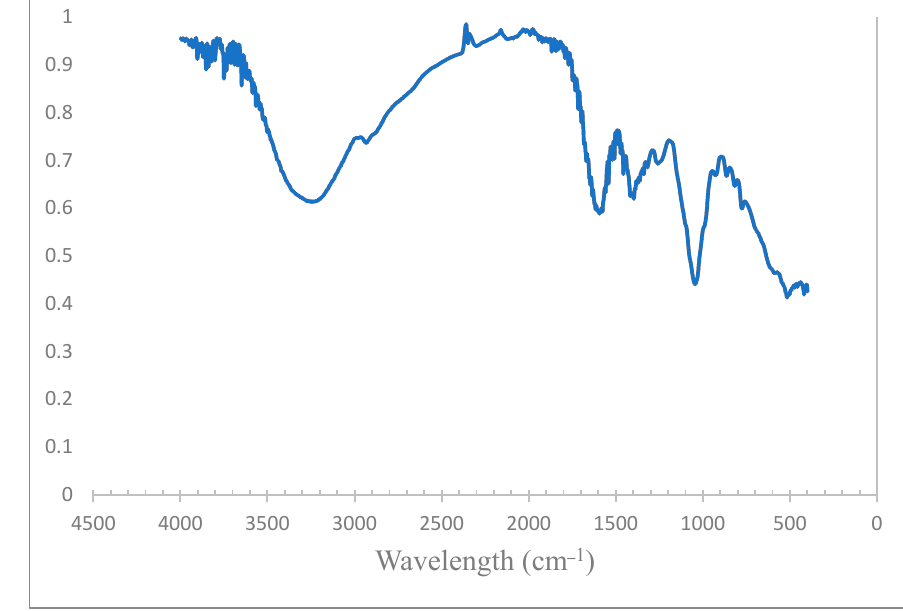
Figure 5. FTIR spectra of okra mucilage.